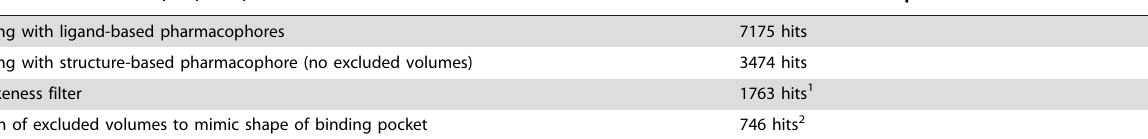
Table 1. Virtual screening of the NCI database.